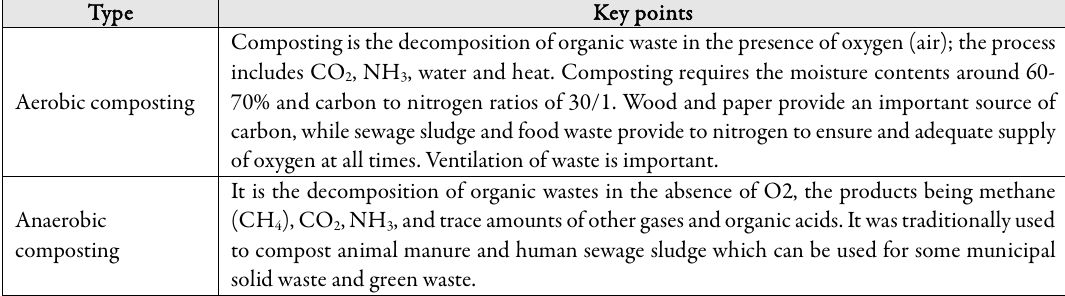
Table 1. Fundamental types of composting aerobic and